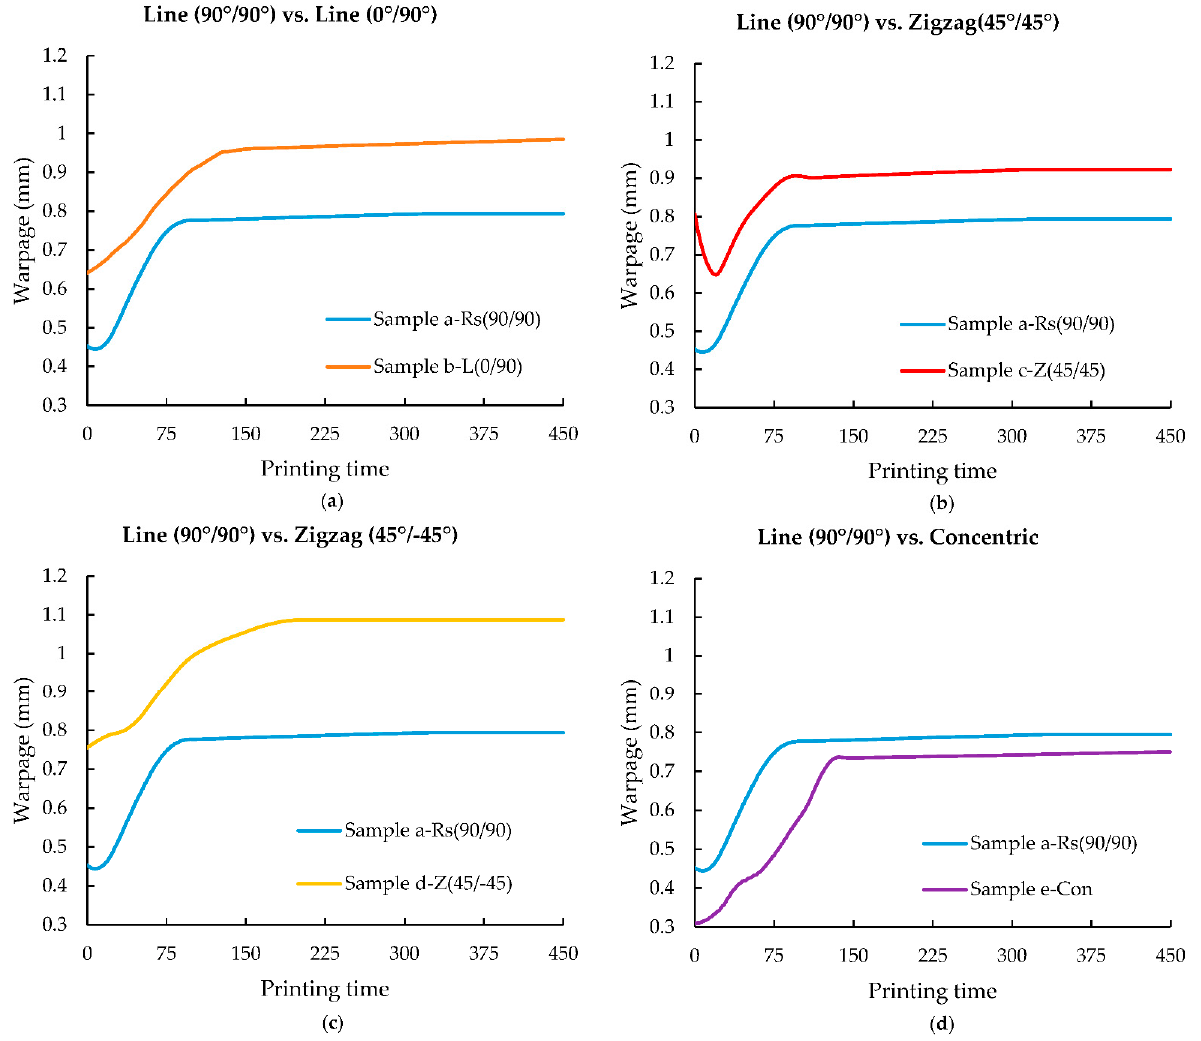
Figure 8. Comparison of warpage results from ( a ) sample b-L (0°/90°), ( b ) c-Z (45°/45°), ( c ) d-Z (45°/ − 45°), ( d ) e-Con plotted against the printing time (dimensionless) and compared with sample Rs (90°/90°) (reference sample).